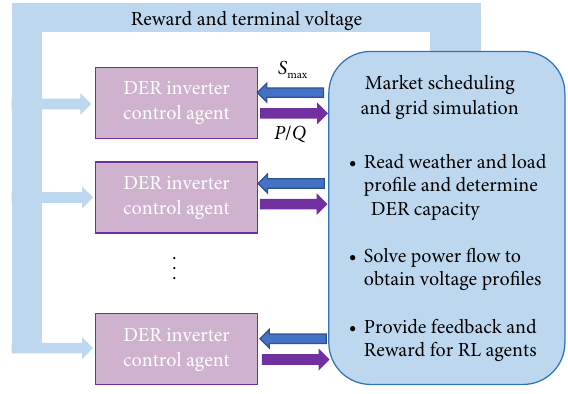
Fig. 7 Agent and environment interaction for voltage support control. To illustrate the capabilities of AI4Dist, we implement the fully decentralized RL-based control proposed in ref. [5] on the same 240-bus distribution system [21] . Agents were trained to collectively maximize the same reward function, in attempt to regulate voltage. Figure 8 illustrates how the collective average rewards in- crease during the training process (top), and how the voltage is driven closer to nominal (bottom).